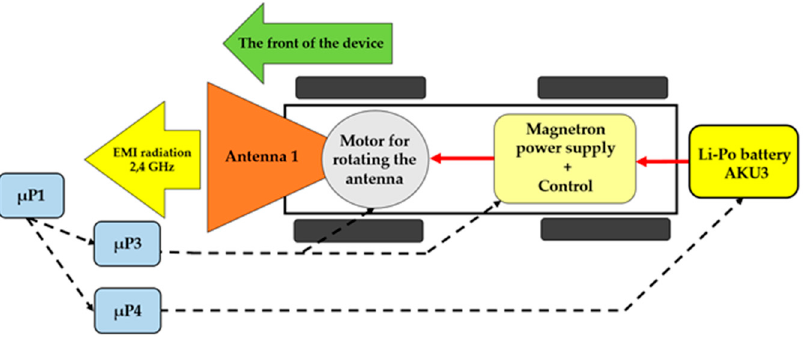
Figure 14. Block diagram of the interference apparatus.